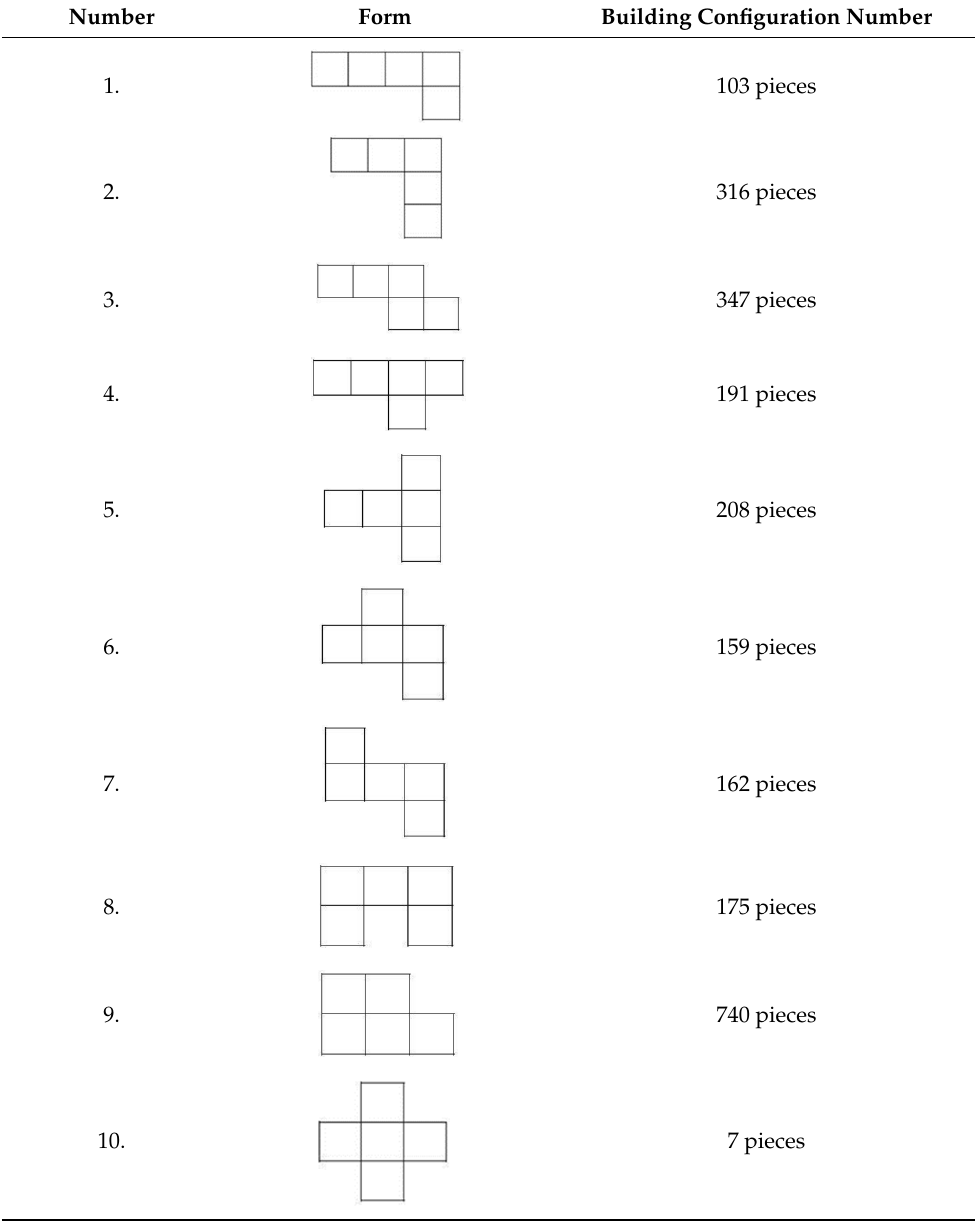
Table 2. Number of building forms and accepted building configurations.